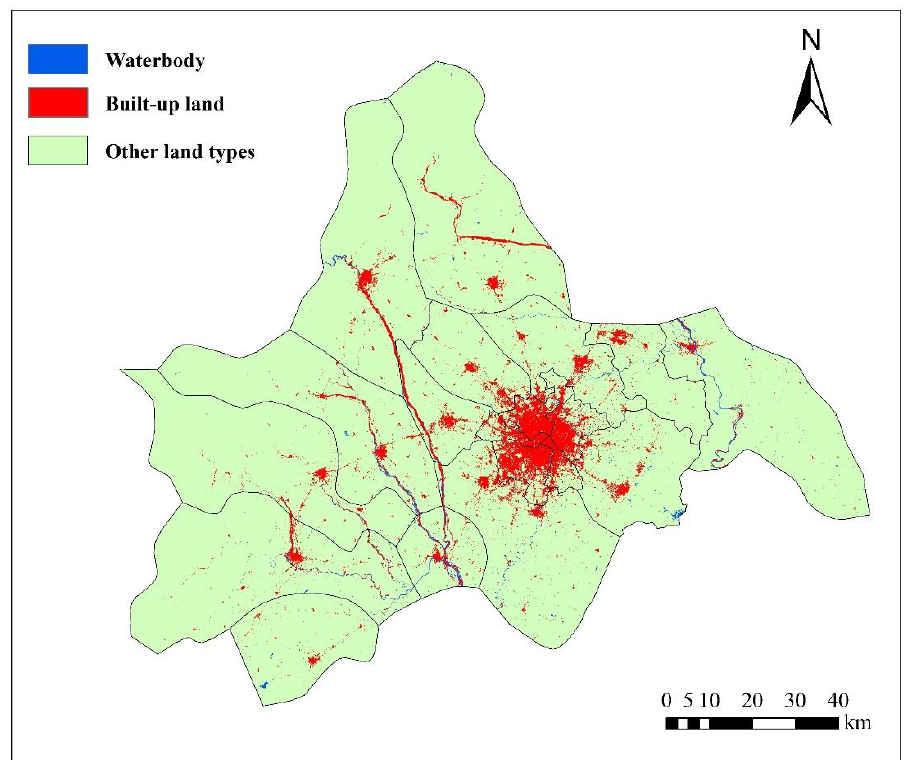
Figure 2. Land-use map of Chengdu in 2005.